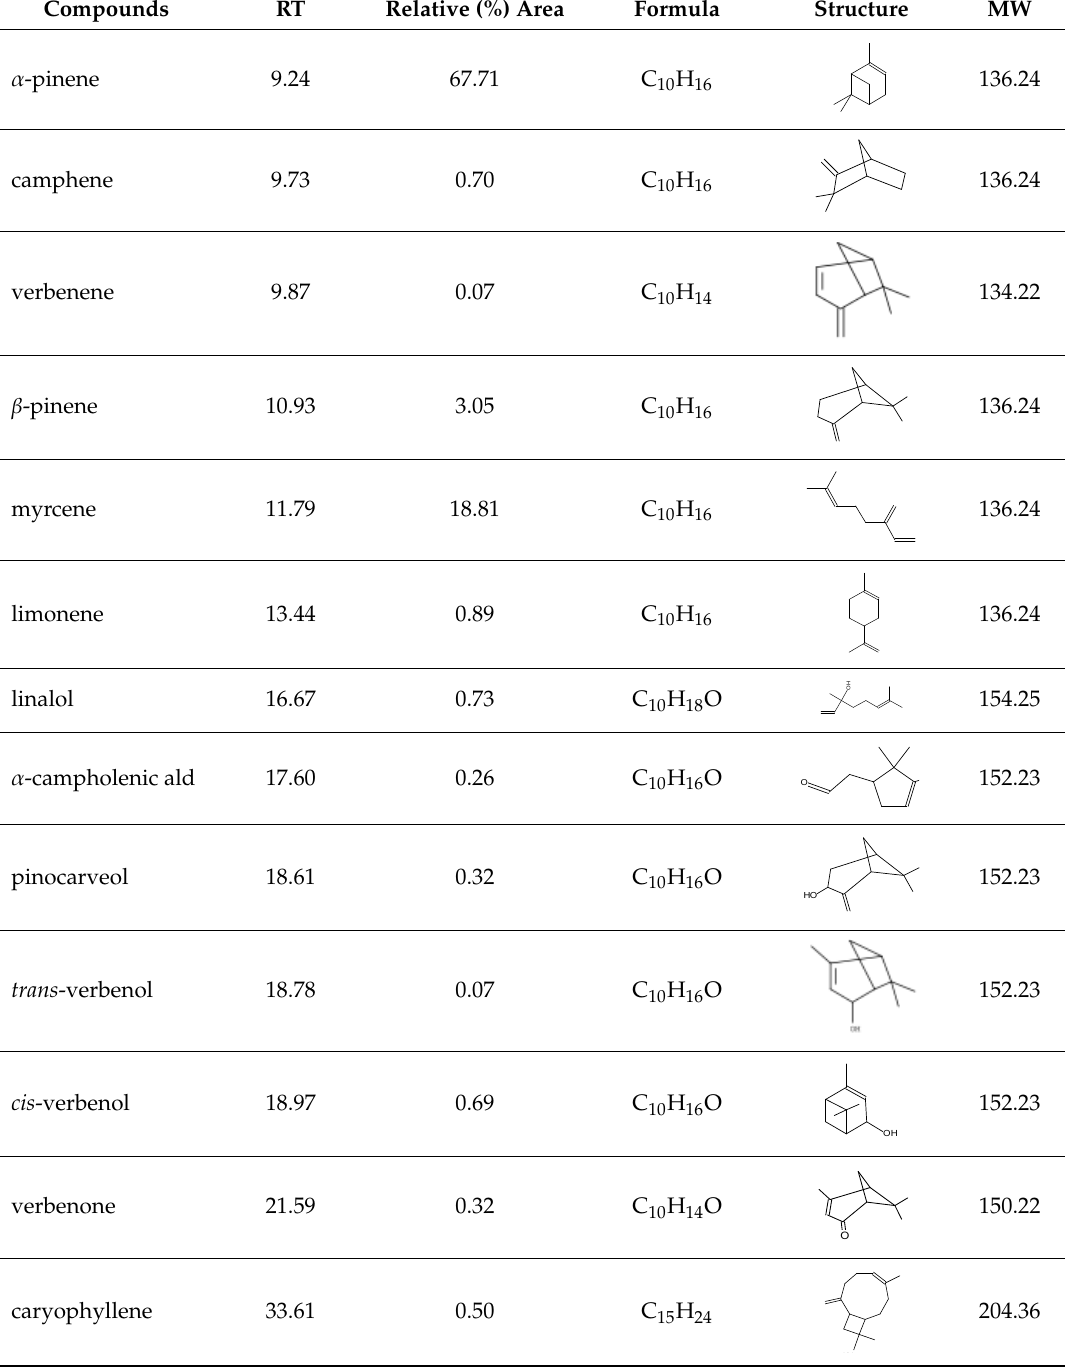
Table 1. Composition of mastic essential oil. The semi-transparent mastic resin was obtained as a trunk exudate from the mastic tree. Mastic essential oil was extracted from the mastic resin by direct gum distillation and analyzed by GC/MS. RT: Retention time; MW: Molecular weight. Compounds RT Relative (%) Area Formula Structure MW